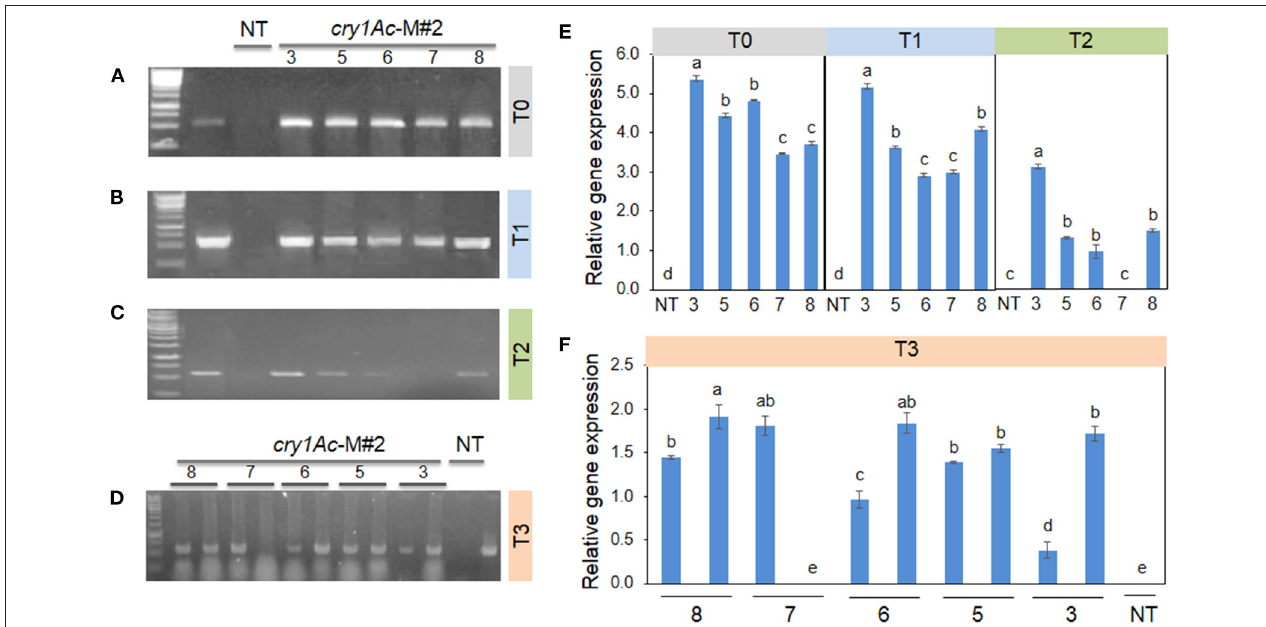
FIGURE 6 | Cry1Ac mutant (M#2) expression in transgenic plants from T0 to T3 generations. Among these 3, 5, 6, 7, 8 are transgenic lines and non-transgenic plants (NT). Cry1Ac mutant (M#2) gene expression of five plants (A–C) left to the right border, in which lane 1 (marker 1kb), lane 2 (plasmid contained pB2WG7 vector), lane 3 negative plant (VX93 non-transgenic, NT), lanes 4 to 8 T0 and T2 generation for cry1Ac mutant (M#2), respectively. (D) showed 10 plants in the T3 generation (from lanes 2 to 11), therein lane 1 is maker 1kb, lane 12 is a negative plant (VX93 non-transgenic), and lane 13 is plasmid contained pB2WG7 vector). Relative gene expression of T0 to T2 (E) , and T3 (F)